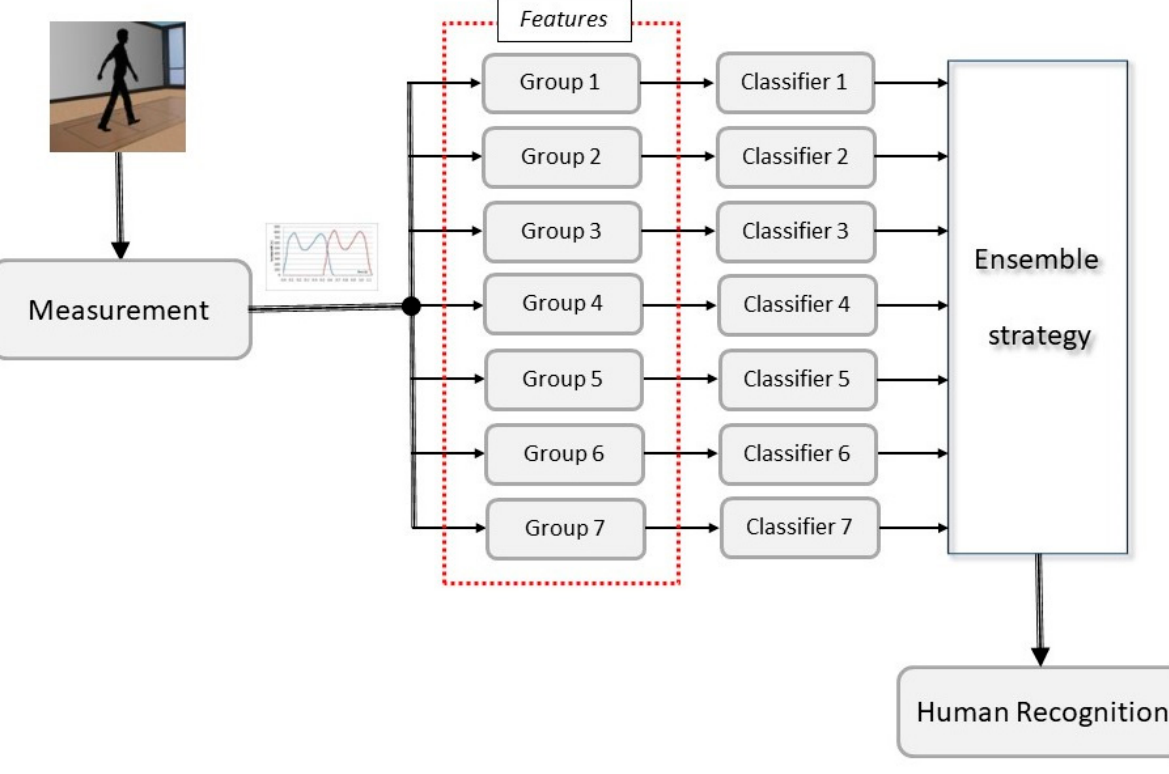
Figure 1. The overall flowchart of the proposed idea.